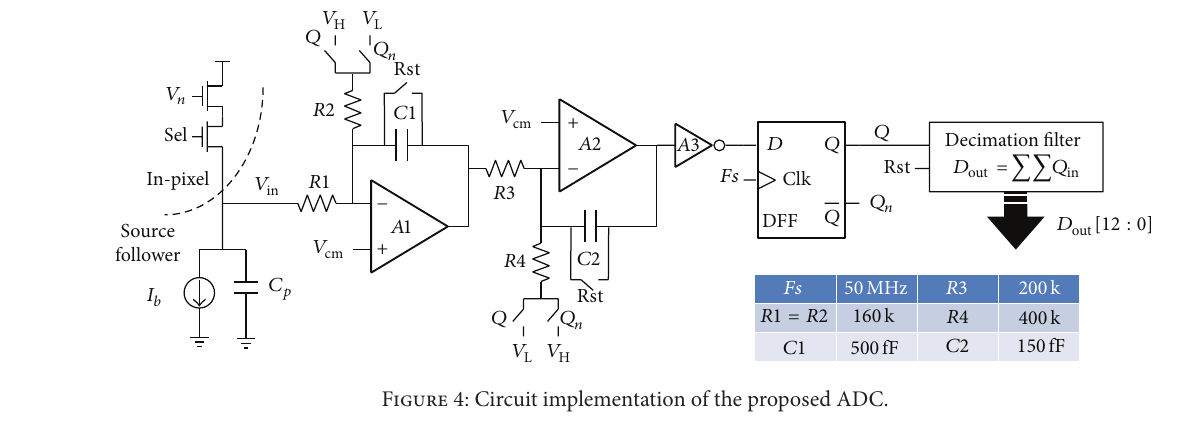
Figure 4: Circuit implementation of the proposed ADC.